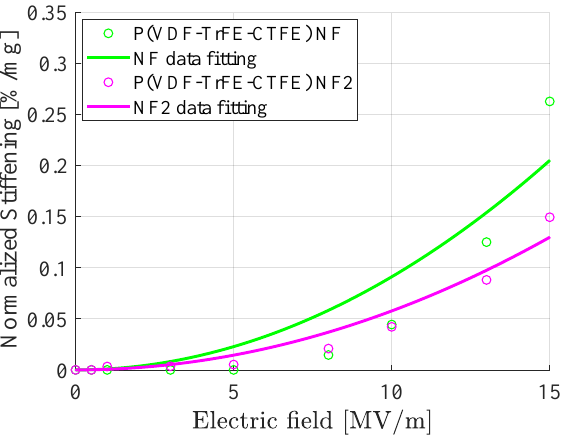
Figure 15. Normalized stiffening plot in the uniaxial tensile load test for two P(VDF-TrFE-CTFE) nanofibers (NF and NF2) mats. NF weights 0.0232 g, while NF2 0.0166 g (see Table 1). Figure 16 derives the value of electrostrictive coefficient Q for the P(VDF-TrFE-CTFE) film by using Equation (3). In particular, the maximum contraction forces F e (measured at steady state, i.e., after ∼ 10 s from the application of the electric field, in the uniaxial load test for the P(VDF-TrFE-CTFE) film against different electric fields and reported in Figure 11a) have been plotted against the field-dependent stiffness K ( E ) (experimentally derived and reported in Figure 14a) multiplied by the square of the polarization P . It can be noted that the electrostrictive coefficient Q is experimentally calculated by linear fitting and has a value of 0.846 m 4 /C 2